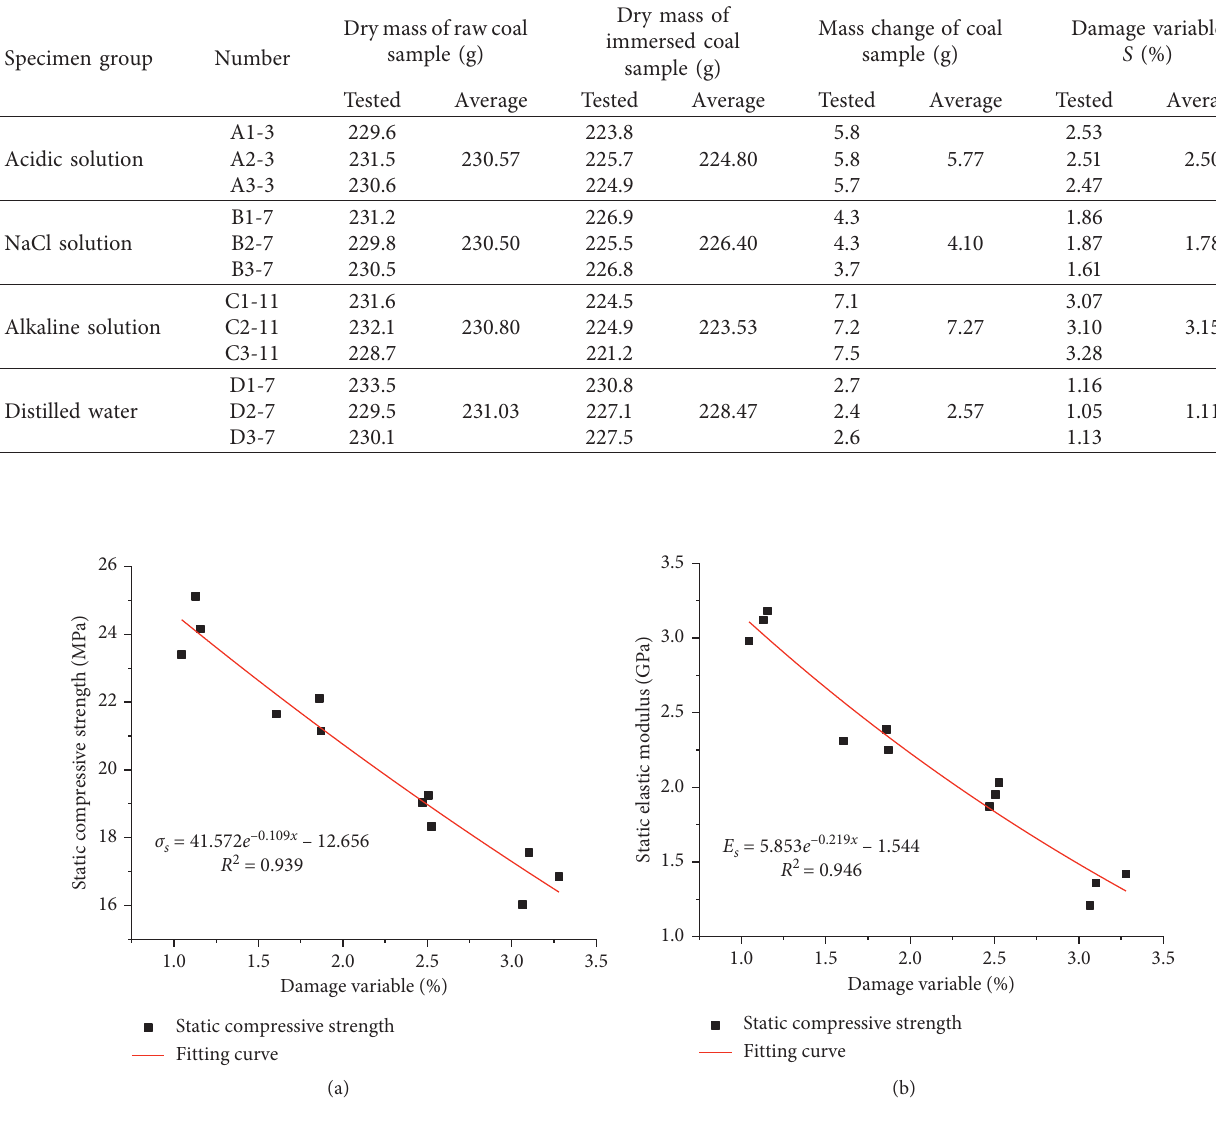
Figure 9: Relationship between static mechanical parameters and damage variables for samples immersed in chemical